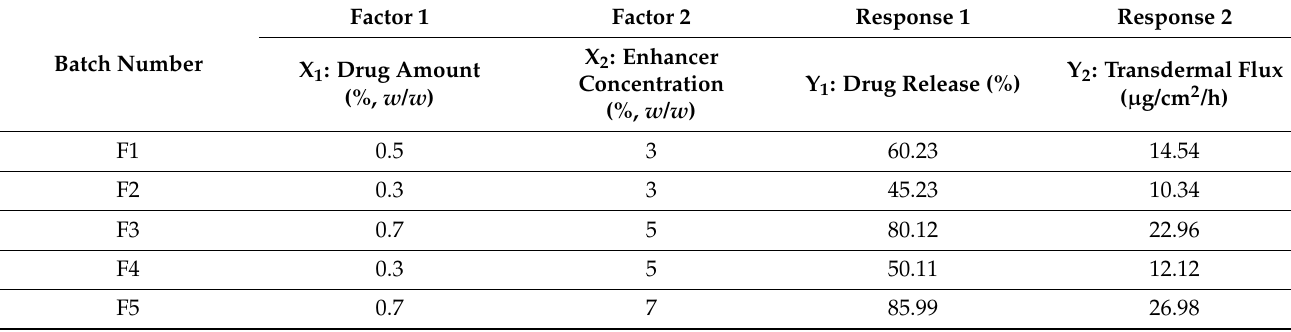
Table 4. Factors used and their response during